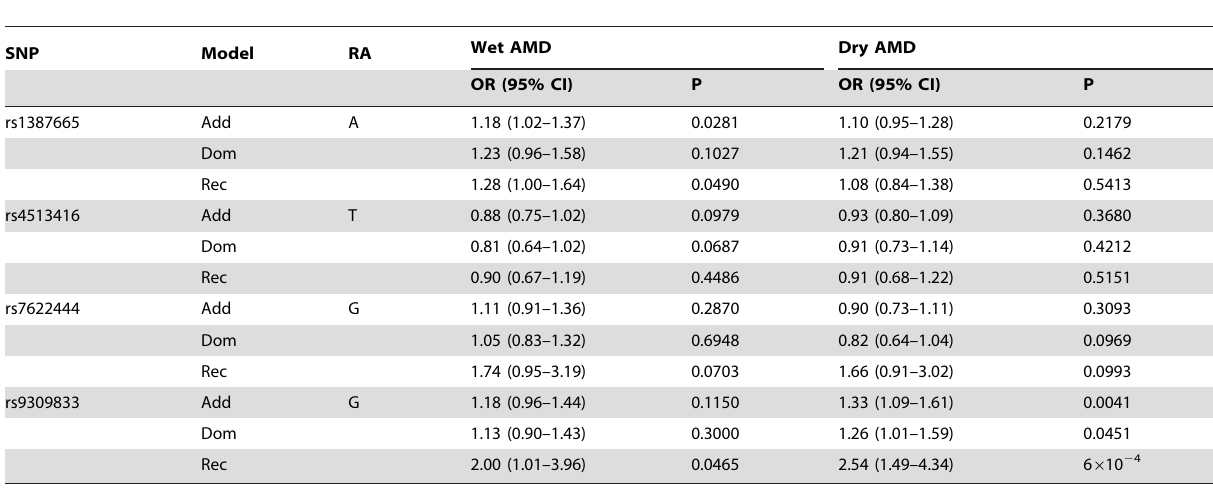
Table 4. Association results of ROBO1 SNPs for wet AMD or dry AMD in meta-analysis under the three different genetic models (additive, dominant, and recessive) from the combined dataset including the NESC, the GREEK, and the NHS-HPFS